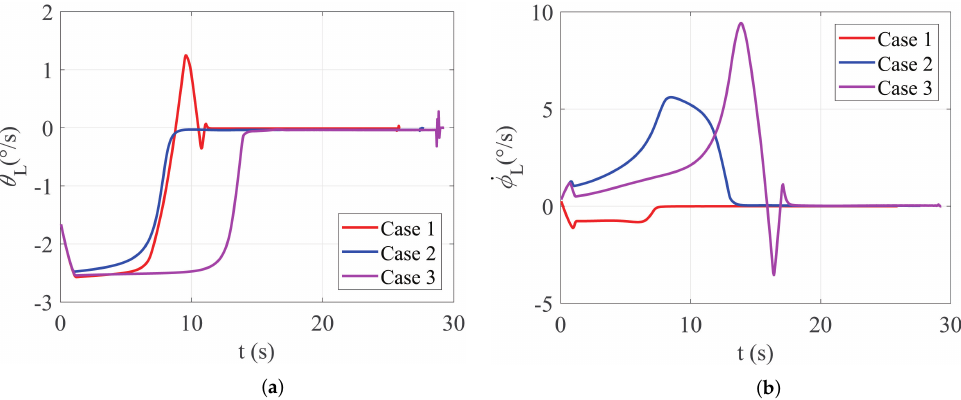
Figure 10. Variations of LOS rates against variable maneuvering targets: ( a ) LOS rates in pitch plane; ( b ) LOS rates in yaw